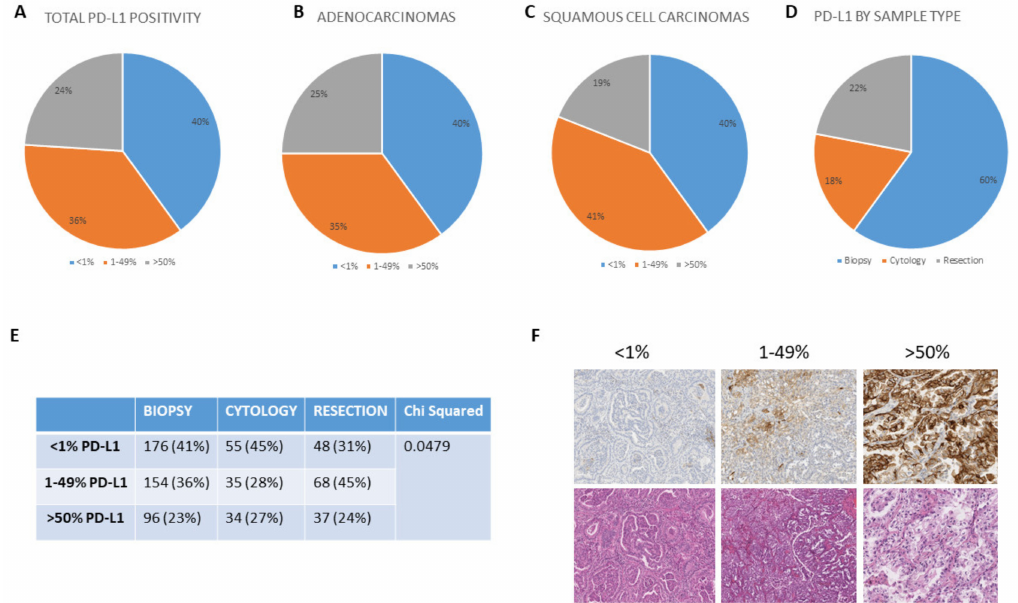
Figure 1. Comparable categorical distribution of programmed death ligand 1 (PD-L1) expression in ( A )